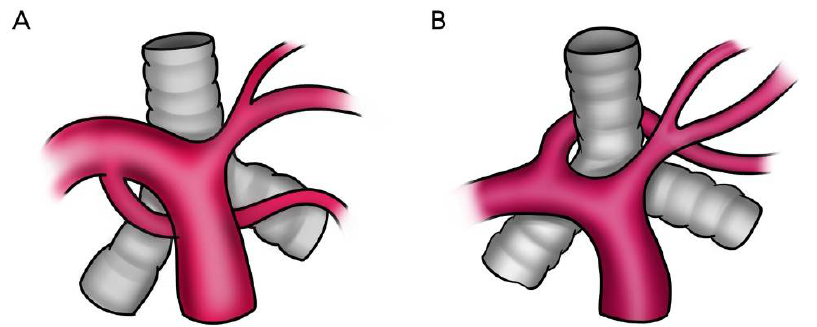
Figure 2. Schematic diagram of two representative patterns of PALPA branching and their anatomic relation with the tracheobronchial tree. ( A ) The anomalous duplicated left pulmonary artery origi- nates from the inferior aspect of the right pulmonary artery and passes to the left anteriorly to the tracheobronchial tree. ( B ) The anomalous duplicated left pulmonary artery arises from the posterior–superior right pulmonary artery and passes to the left hilum between the trachea and the esophagus (not shown).